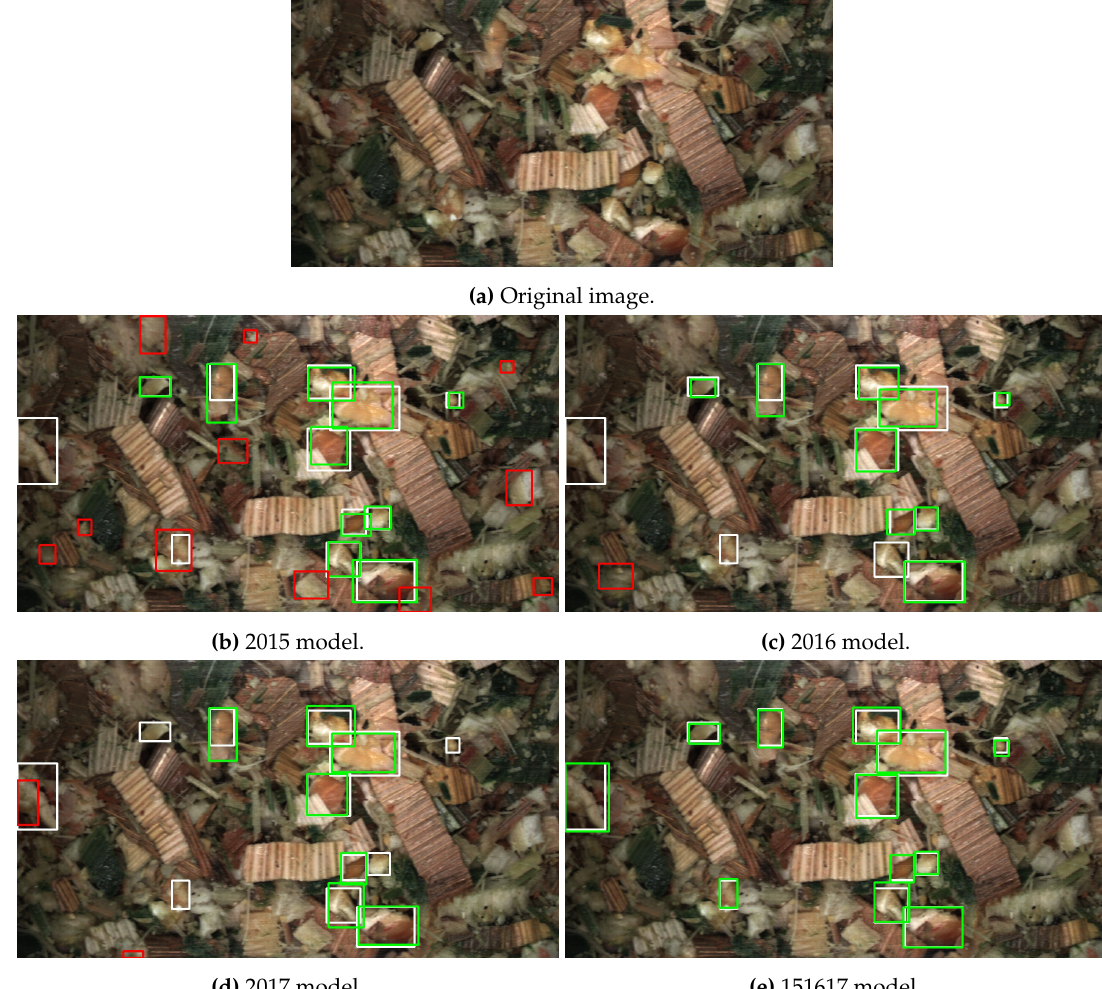
Figure 7. Model predictions on a test image from 2016. Bounding-boxes colours indicate ground truth ( white ), true positive ( green ) and false positive ( red ). True positives and false positives evaluated at an IoU threshold of